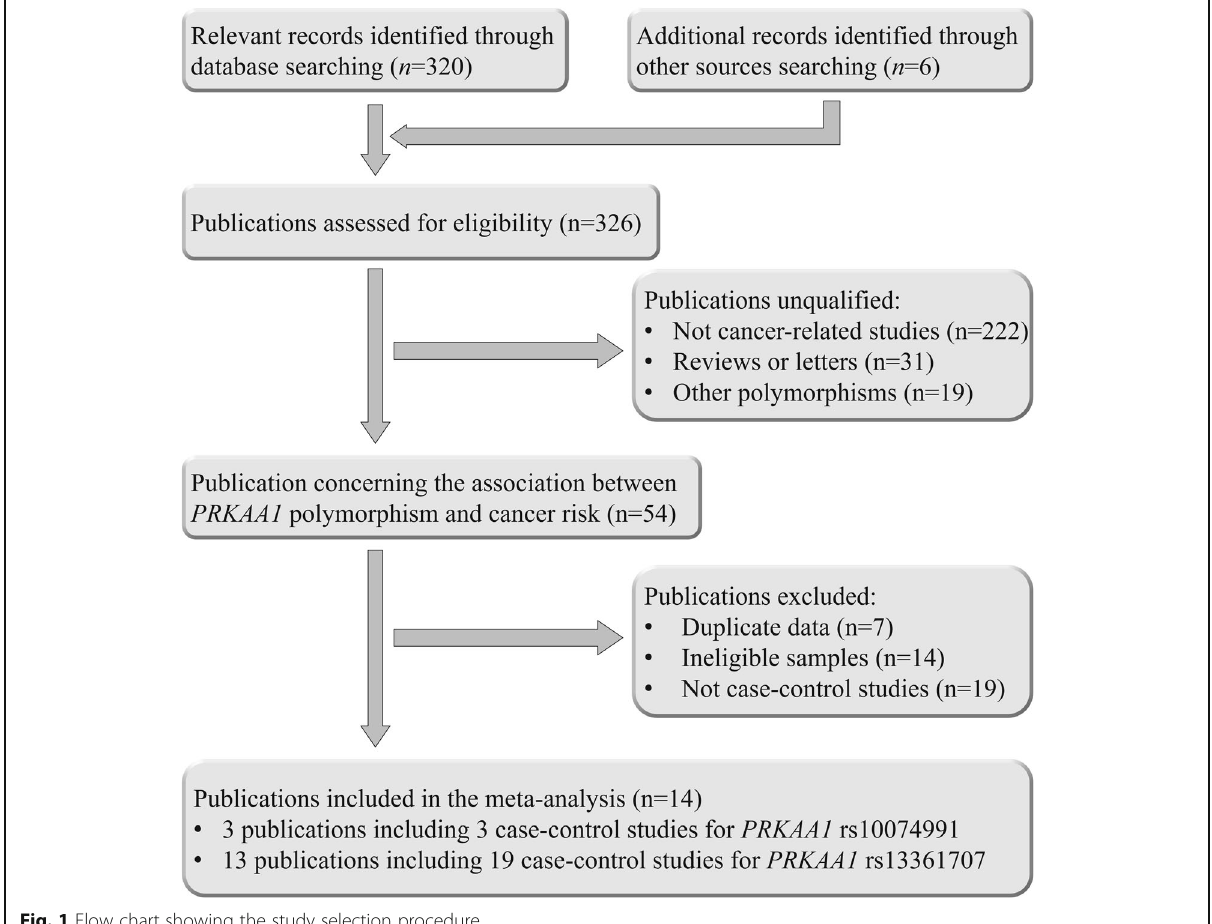
Fig. 1 Flow chart showing the study selection